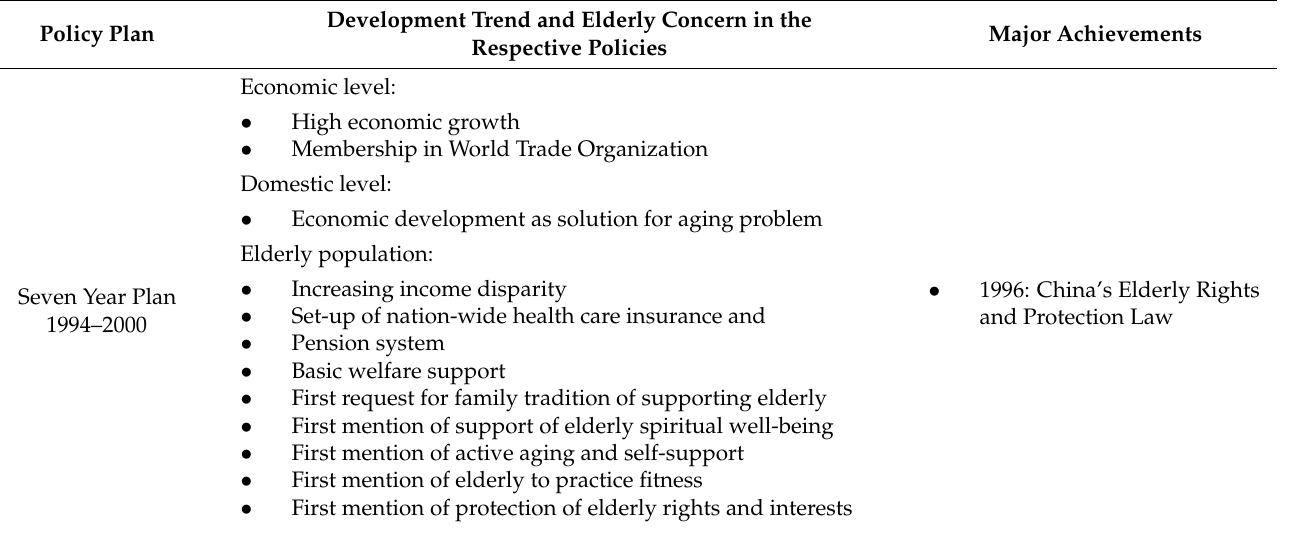
Table 1. Highlights of China’s elderly care policies